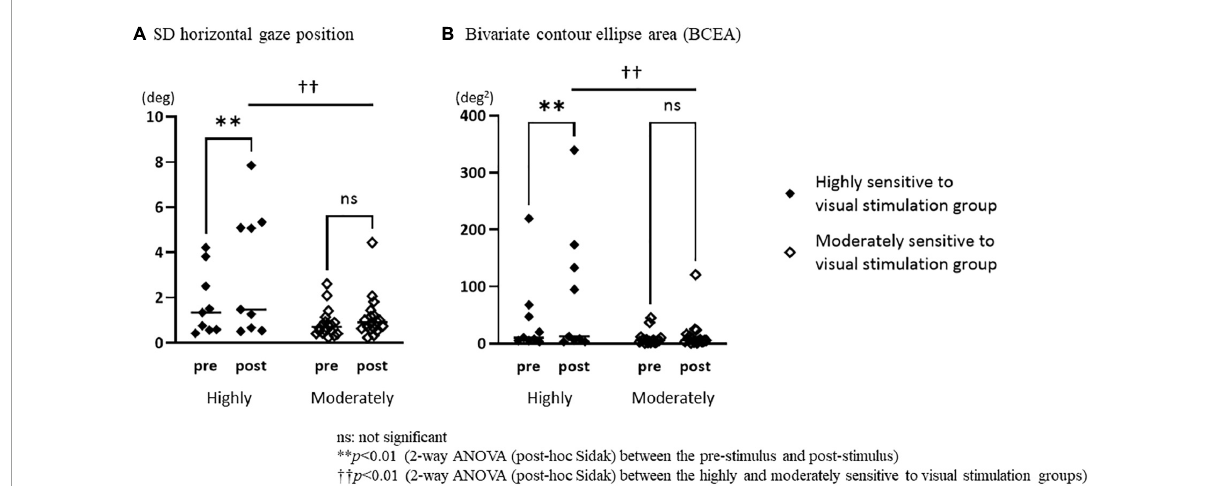
FIGURE4 Comparisons of the standard deviation of the horizontal gaze position and bivariate contour ellipse area in the pre-stimulus and post-stimulus states between the highly and moderately sensitive to visual stimulation groups. (A) The standard deviation (SD) horizontal gaze position was significantly greater post-stimulus than pre-stimulus ( p = 0.002, r = 0.69) in the highly sensitive to visual stimulation group, and the SD horizontal gaze position of the highly sensitive to visual stimulation group was significantly greater than that of the moderately sensitive to visual stimulation group ( p = 0.003, r = 0.56) in the post-stimulus. (B) The bivariate contour ellipse area (BCEA) was significantly greater post-stimulus than pre-stimulus ( p = 0.002, r = 0.68) in the highly sensitive to visual stimulation group, and the BCEA of the highly sensitive to visual stimulation group was significantly greater than that of the moderately sensitive to visual stimulation group ( p = 0.006, r = 0.53) in the post-stimulus.